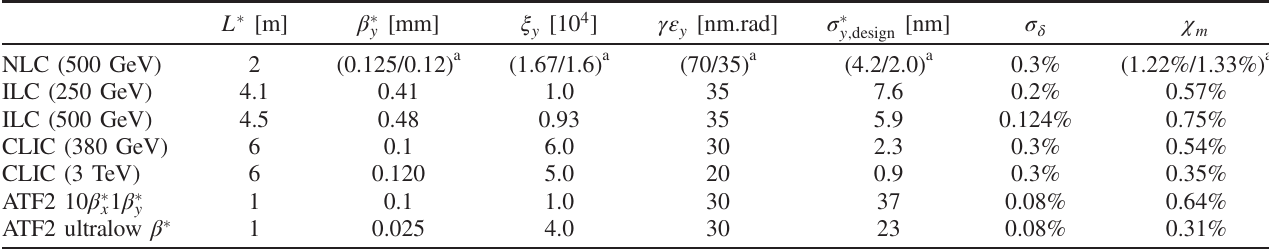
TABLE II. Momentum bandwidths for the ATF2 10 β (cid:1) x 1 β (cid:1) y and ultralow β (cid:1) optics, in comparison with the NLC, ILC, and CLIC baseline designs [1,10,14,39]. ξ y is the vertical chromaticity, γε y the normalized vertical emittance, σ δ the rms momentum spread and χ m the 10% momentum bandwidth. All the assessments employ error-free lattices without synchrotron radiation.